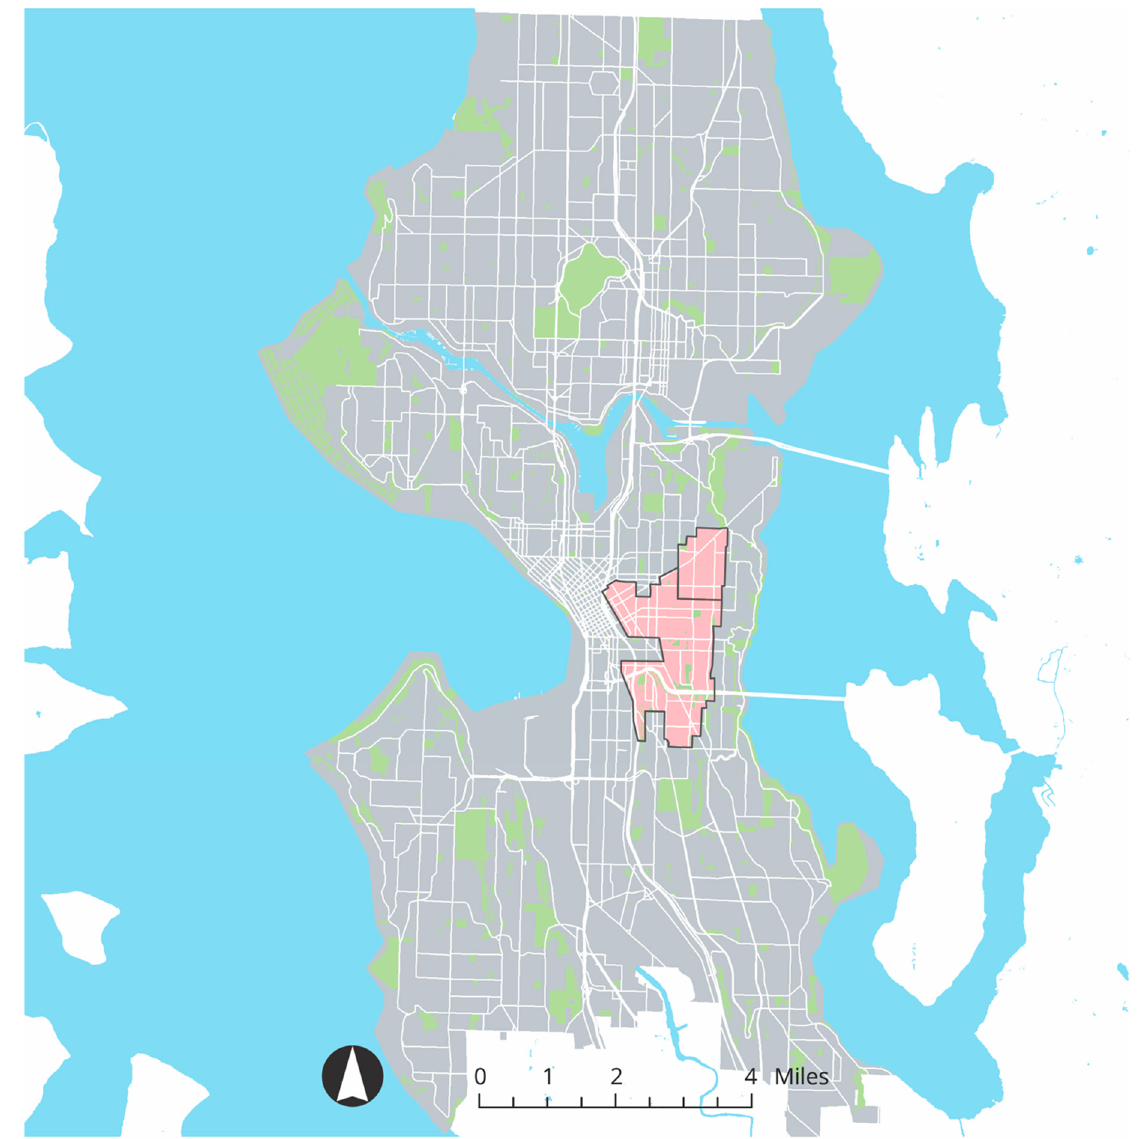
Figure 2. The location of the Central District and its redlined area in Seattle. Source: Mt. Baker Team, 2019. (Building Beloved Community, p. 18).